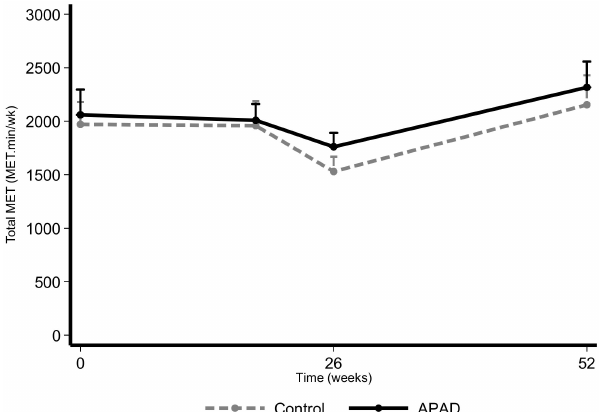
Figure 4. Evolution of the total MET based on the GPAQ according to randomization arm in the intention-to-treat population. Data are presented as mean + SD.